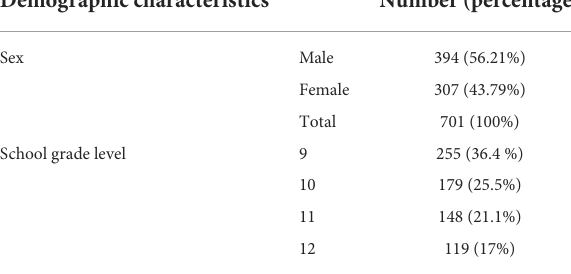
TABLE 3 Demographic characteristics of the